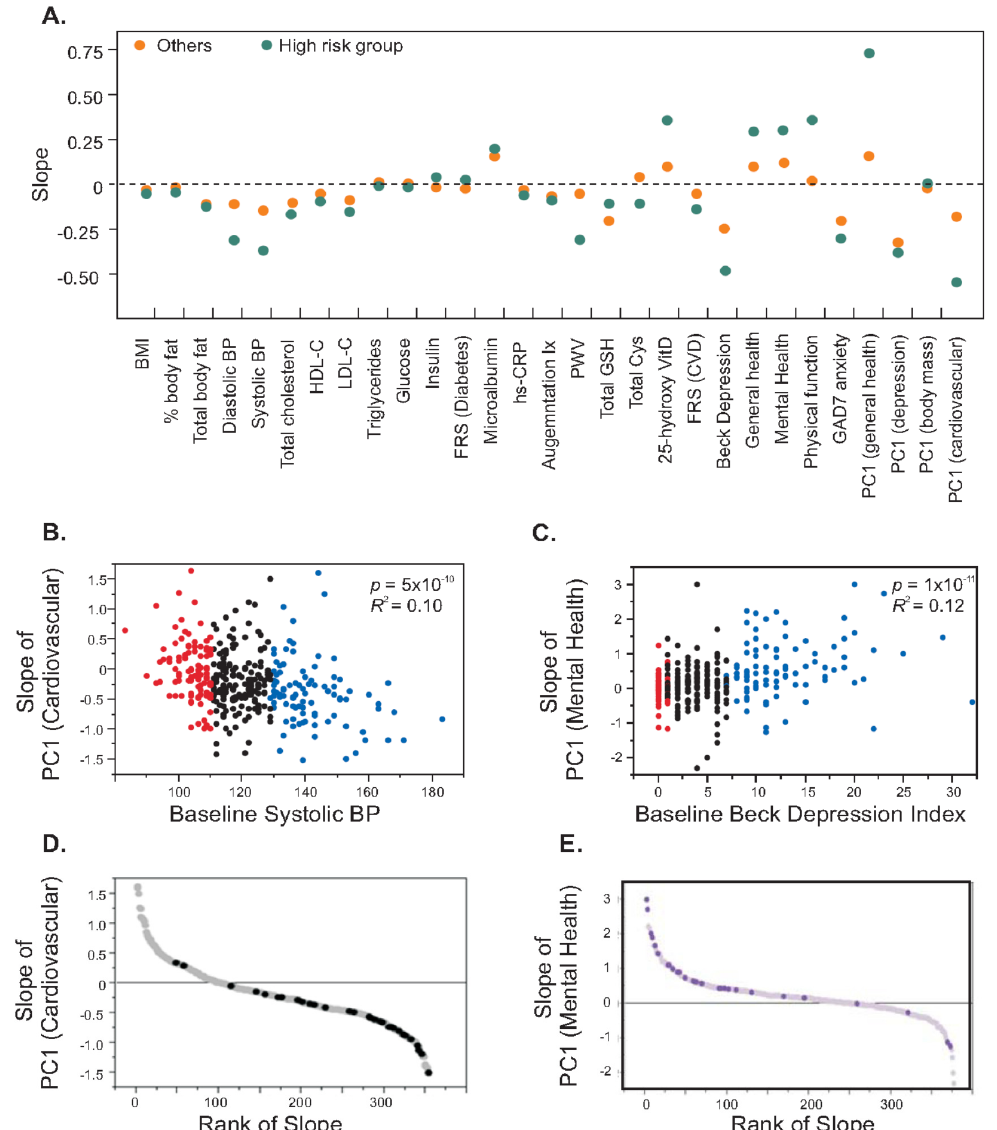
Figure 3. Health improvement in individuals with high CVD risk and low mental and physical health. ( A ) The plot contrasts the slope for the indicated traits for individuals in the high risk quartile of the trait (green), and the remaining three quarters of the cohort (orange). For 14 of the traits there is a significant difference with the change in the desired direction for all but total glutathione (Total GSH); ( B , C ) x-y plots of the slope of PC1 for cardiovascular risk factors or mental health respectively, against baseline systolic blood pressure or Beck depression index. Red and blue colors mark individuals in the bottom and top quartiles. A negative slope for PC1 (cardiovascular) implies improving health, and is greater for individuals with high blood pressure at baseline. A positive slope for PC1 (Mental Health) implies improved health, and is greatest for individuals who were more depressed at baseline; ( D , E ) Plots of the respective slopes by rank, with individuals at combined highest risk of physical and mental disease (in both less healthy quartiles) highlighted, showing enrichment for strong health responses in the desired